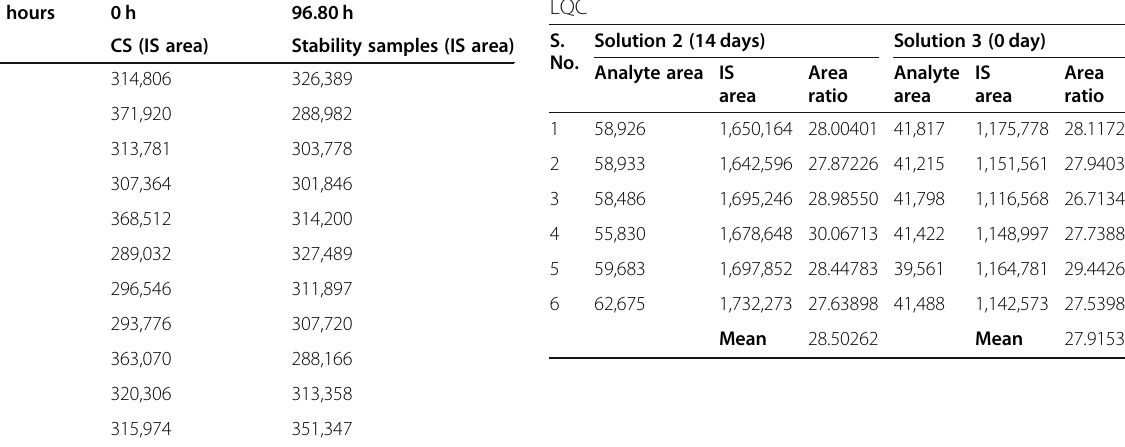
Table 18 Long-term stock solution stability for internal standard